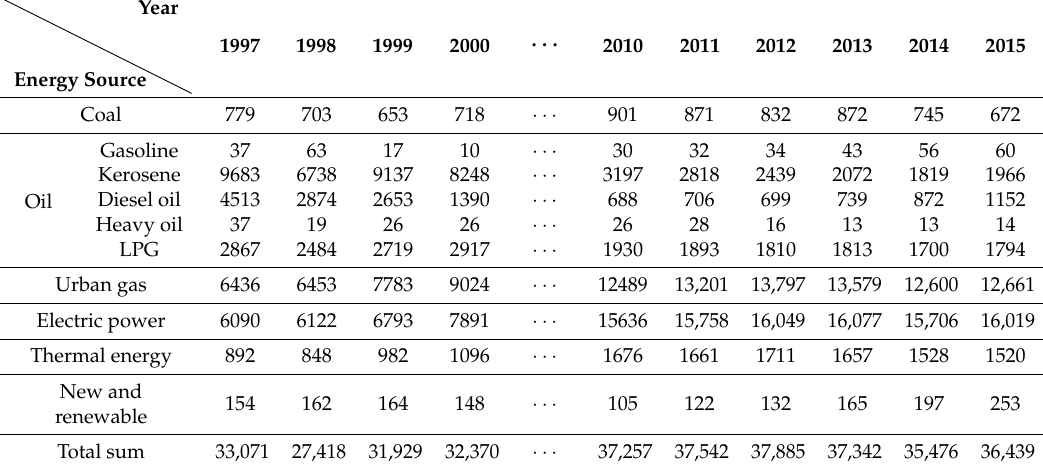
Table 1. Database of building energy consumption. (Unit: 1000 toe).